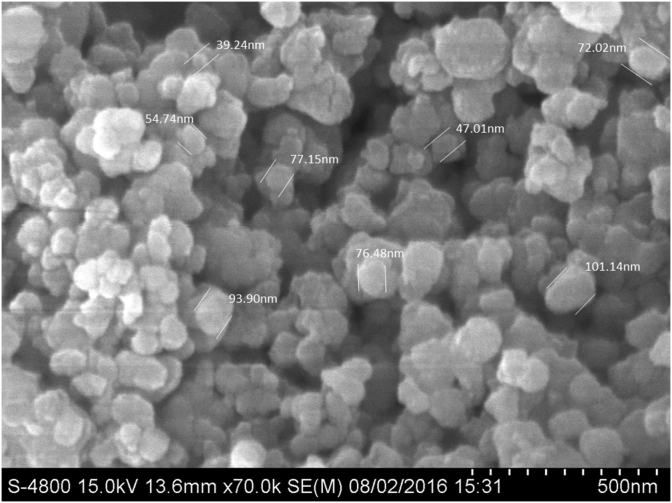
(a) SEM Images of Pb@ZnFe2O4 average particle size 70.21 nm at low magnification.